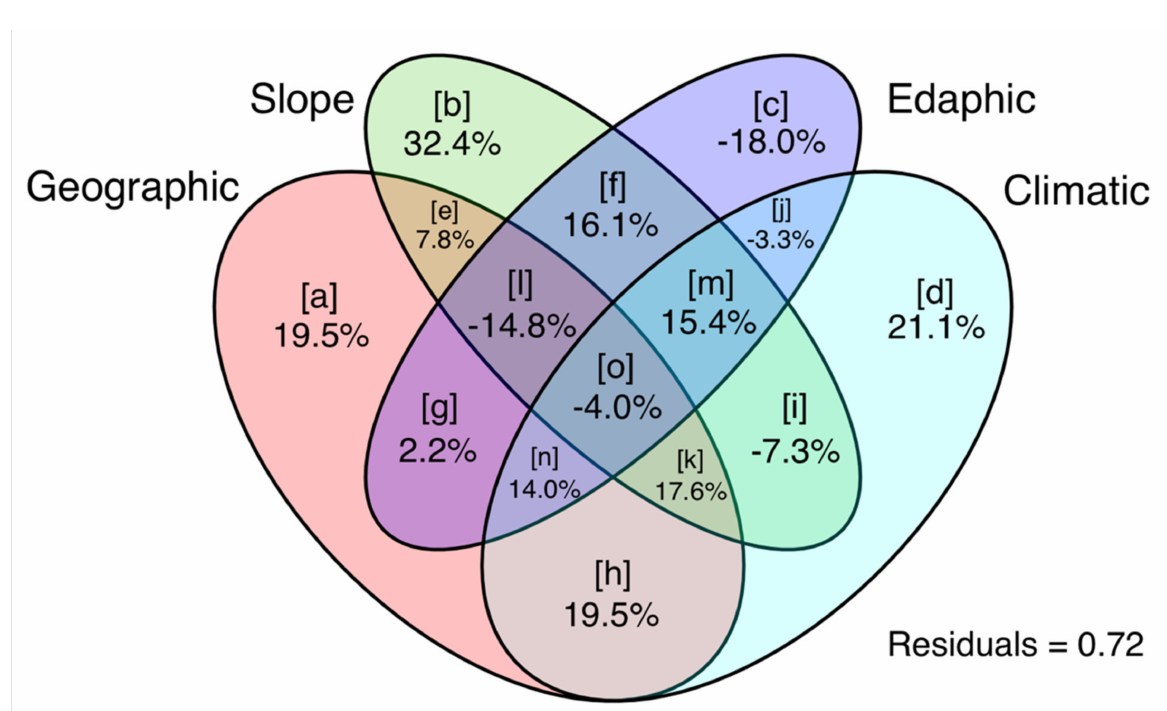
Figure 9. Venn diagram [78] illustrating the variation partitioning results (partial CCA) and contribu- tion (%) of the four major variable classes